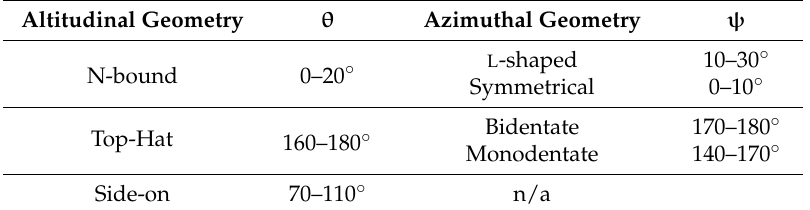
Figure 3. Schematic representation of the geometric angles θ and ψ that define the orientation of NO 2 − bound to T2Cu. Table 2. Angular thresholds for the characterisation of nitrite binding orientations.